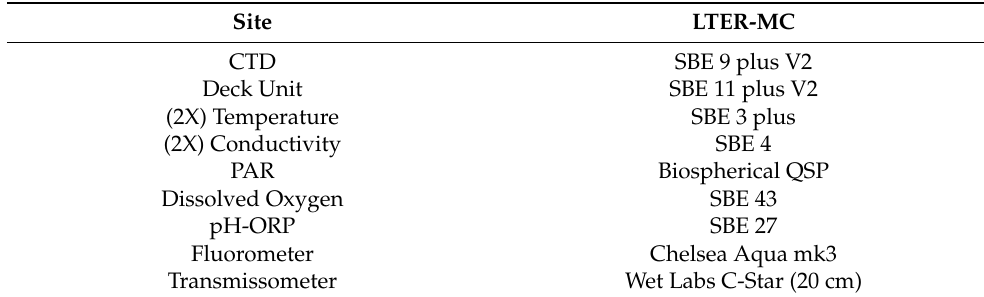
Table 1. CTD unit technical parameters.